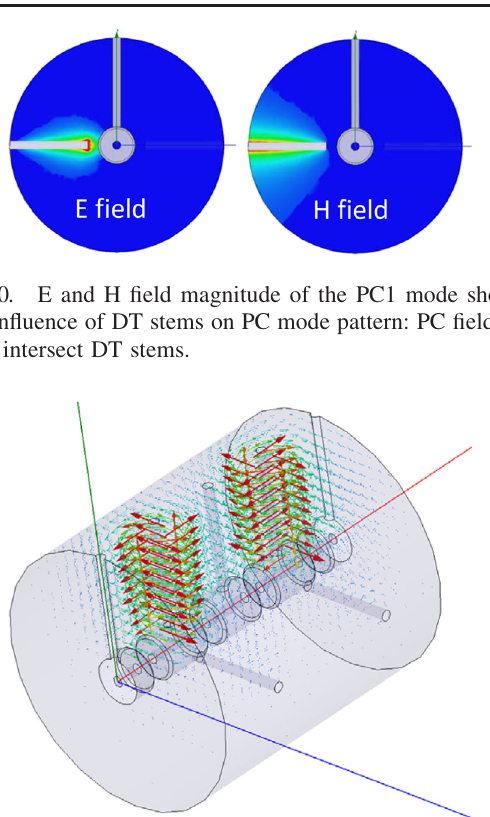
FIG. 13. Frequency bands in the DTL